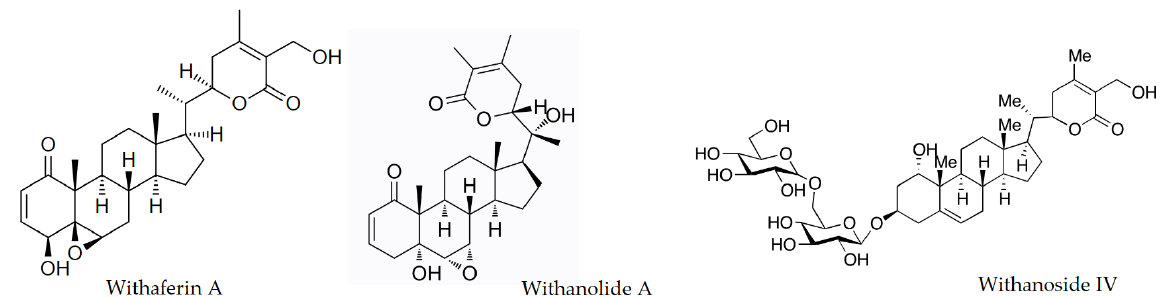
Figure 2. Chemical structures of the main active compounds present in Ashwagandha (Withania somnifera) root.